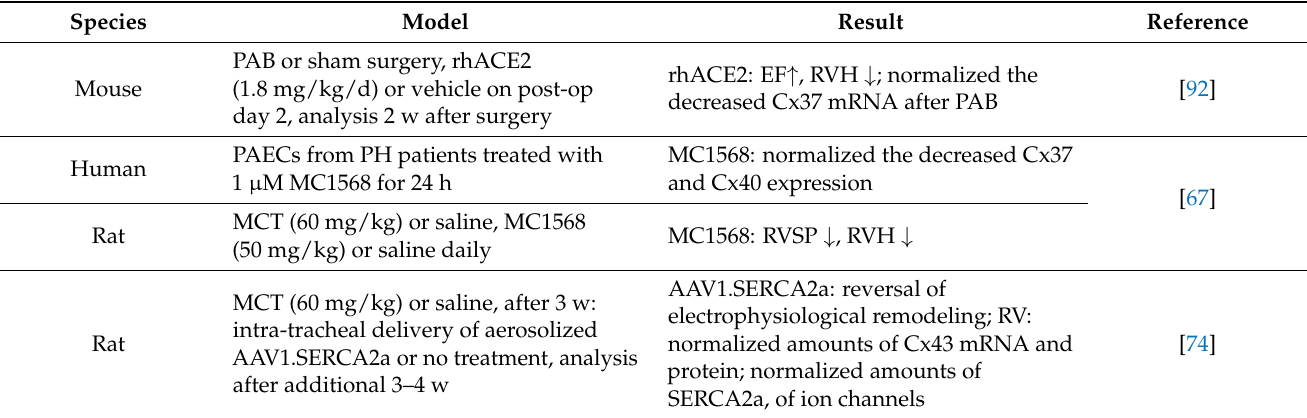
Table 5. Therapeutic approaches to improve RV function in PH involving